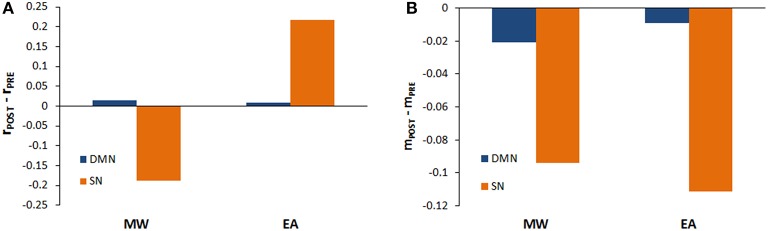
Phase coherence mean and variability during stimulation periods. (A) Mean of the phase coherence (rPOST – rPRE) for the DMN and the SN when rdmn>rsn (MW) and rdmn<rsn(EA). (B) Phase coherence variability (mPOST – mPRE) for the DMN and the SN when rdmn>rsn (MW) and rdmn<rsn(EA).